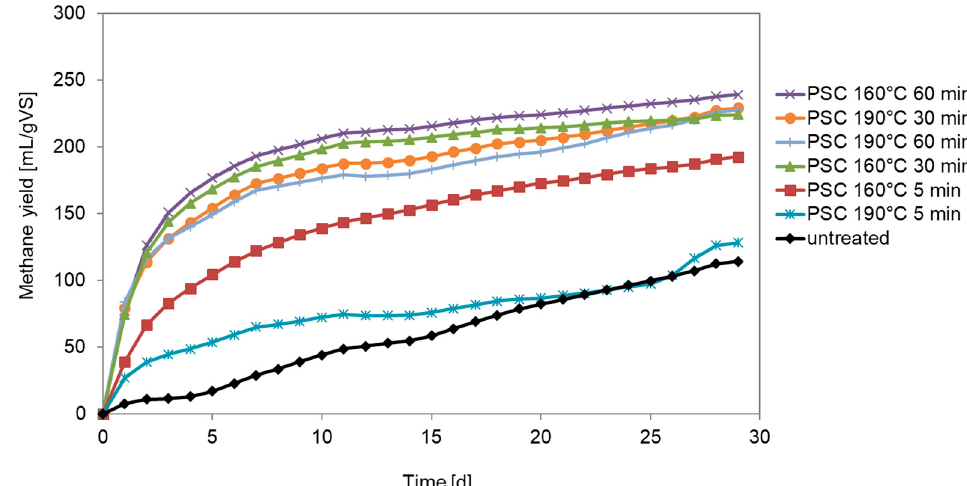
Figure 1. Methane yields in BMP tests.